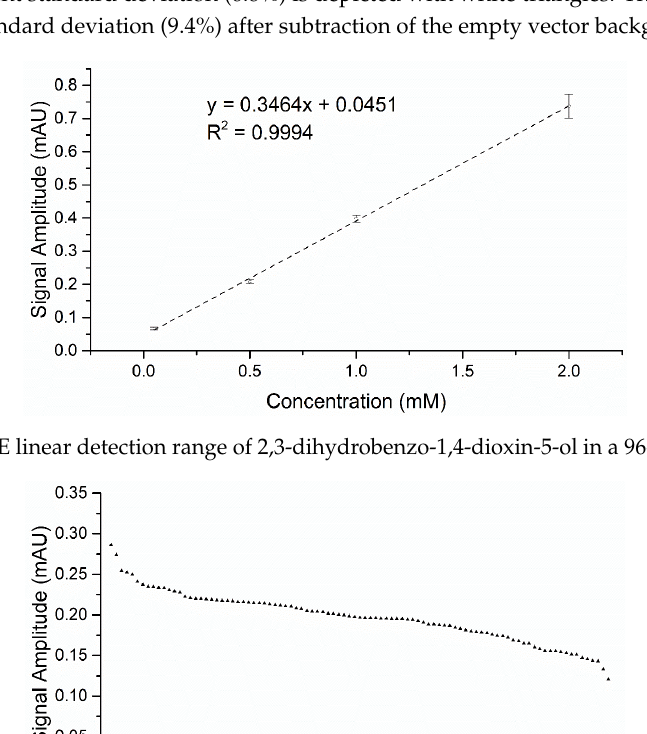
Figure A3. The CE linear detection range of 2,3-dihydrobenzo-1,4-dioxin-5-ol in a 96-well MTP format.